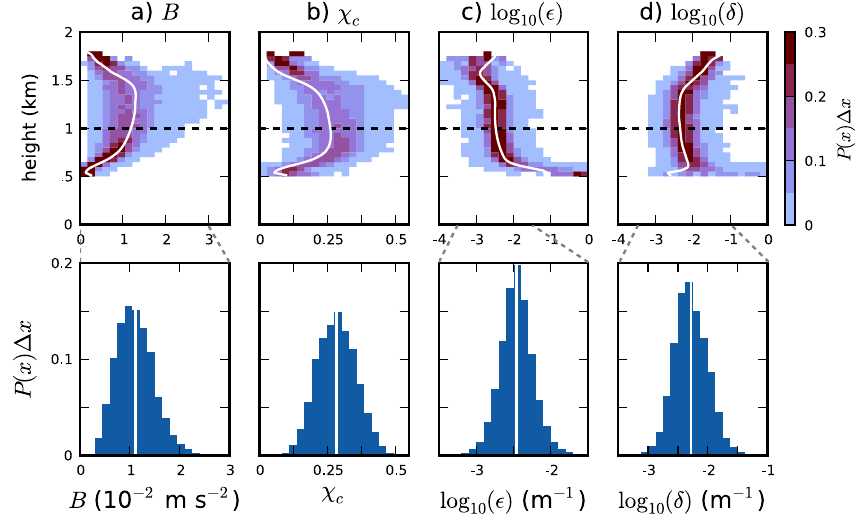
Fig. 4. Probabilities in range 1x ( P(x)1x ) at each model height (top row) and at 1km height (bottom row) for cloud core (a) buoyancy, (b) critical mixing fraction, (c) log 10 of the fractional mass entrainment, and (d) log 10 of the fractional mass detrainment in the BOMEX LES output. White lines indicate the horizontal mean of each variable conditionally sampled on the cloud core over the entire model domain.